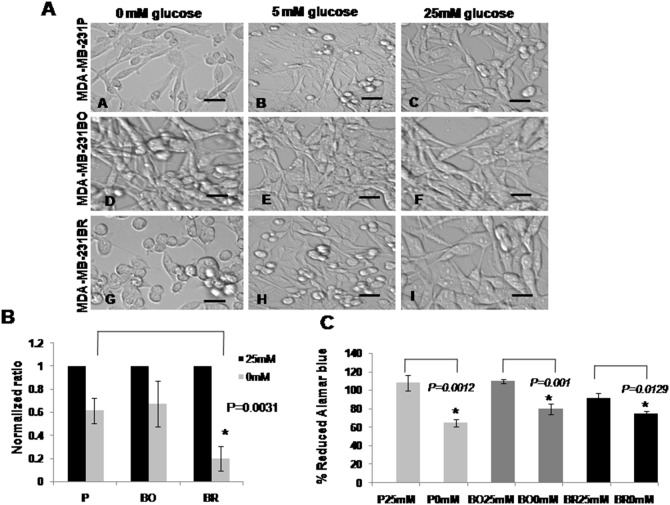
Hypoglycemia caused a change in MDA-MB-231BR cell morphology.Phase contrast images of the three MDA-MB-231 cell lines. Image (A) shows MDA-MB-231P cells grown in DMEM 0 mM glucose images; (B–C) the same cells grown in DMEM with different glucose concentrations: 5 mM and 25 mM. Image (D) represents MDA-MB-231BO cells growing in DMEM 0 mM glucose; images (E–F) are for the same cells grown in the other glucose concentrations. Neither MDA-MB-231P nor MDA-MB-231BO cells were morphologically changed by the various changes in glucose concentration. The MDA-MB-231BR cells grown in the absence of glucose for 24 hrs lost their extended protrusions (G), became rounded and maintained their attachment to the culture plate; images (H and I) show how the shape of the cells was restored upon the increase in glucose concentration. Scale bars = 100 µm. Breast cancer cells formed fewer colonies and had reduced proliferation under hypoglycemic conditions. (B) Graph represents the ratio of the average number of colonies counted in four independent experiments. The y-axis represents the normalized number of colonies counted in the hypoglycemia exposed wells versus the control formed by the cells. MDA-MB-231BR cells produced the least colonies among the three cell lines when exposed to hypoglycemia and this was confirmed by running the non-parametric Kruskal Wallis test H = 15.66 and p = 0.0013. (C) The graph represents cell growth as the percentage of Alamarblue reduced by the cells under hypo/hyperglycemia. There was a significant decrease in the reduced Alamarblue when the cells were grown in hypoglycemia for 24 hrs (MDA-MB-231P, MDA-MB-231BO, and MDA-MB-231BR) Results are shown as mean ± SD and were statistically analyzed by a two-tailed student’s t test (n = 3).